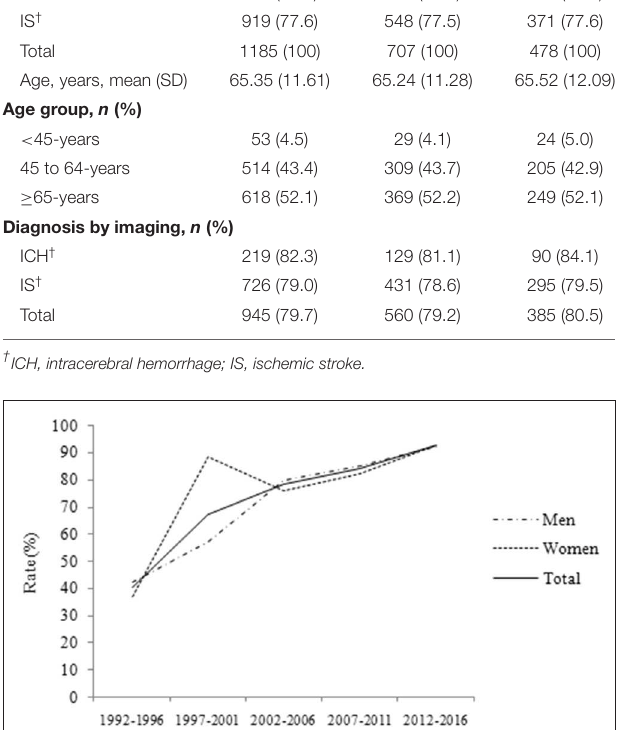
diagnoses increased for both sexes over the study period ( P